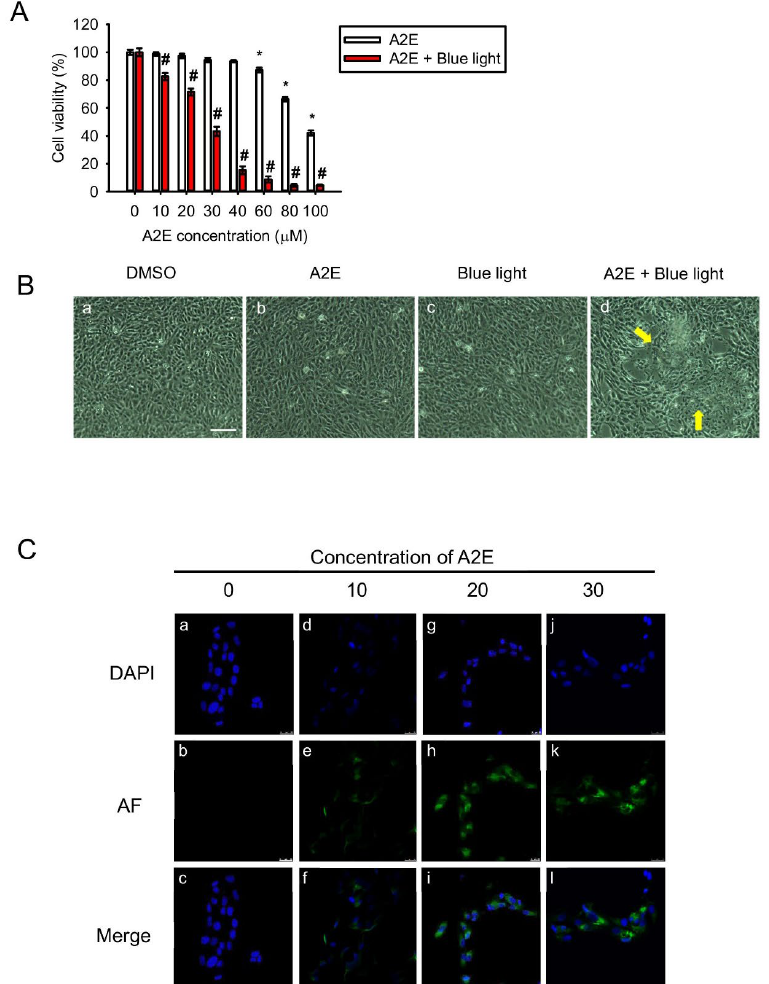
Figure 1. Blue light damages A2E-laden retinal pigment epithelial (RPE) cells. ( A ) Cell viability (%) was measured using the 3-(4,5-dimethyl-2-thiazolyl)-2,5- diphenyl-2H-tetrazolium bromide (MTT) assay. A2E-laden RPE cells with or without blue light-emitting diode (LED) light (BLL) treatments were compared with control cells in the dark; 6 independent experiments were performed with three each. White bars indicate RPE cells exposed to 0, 10, 20, 30, 40, 60, 80, and 100 µ M synthetic A2E for 12 h. Red bars indicate RPE cells co-treated with BLL for 12 h (460 nm, 150 lux) and the indicated concentration of synthetic A2E (0, 10, 20, 30, 40, 60, 80, and 100 µ M). Data represent the average percent cell viability ± SE. * p < 0.05 was considered statistically significant compared to controls. # p < 0.05 compared with the A2E group. ( B ) Morphology of A2E-laden RPE cells with or without BLL exposure is shown. ( a ) A representative figure of RPE cells grown to confluence and loaded with dimethyl sulfoxide (DMSO)as a vehicle control. ( b ) A representative figure of RPE cells grown to confluence and loaded with 30 µ M A2E. ( c ) A representative figure of RPE cells exposed to BLL for 12 h. ( d ) A representative image of RPE cells co-treated with 30 µ M A2E and exposed to BLL for 12 h is shown. RPE cells were observed to have a slim and shrinking morphology (indicated by yellow arrows). Results from 3 independent experiments are shown (N = 3). Scale bar, 100 µ m. ( C ) Photographs showing A2E-laden RPE cell autofluorescence are presented. RPE cells were loaded with the indicated concentration of A2E (10, 20, and 30 µ M) for 12 h. Immunofluorescence showing 4 (cid:48) -6-diamidino-2-phenylindole (DAPI) staining (blue) in the cell nuclei and localized autofluorescence (green) in A2E cells is presented. Results from 5 independent experiments are shown (N = 5). Scale bar, 25 µ